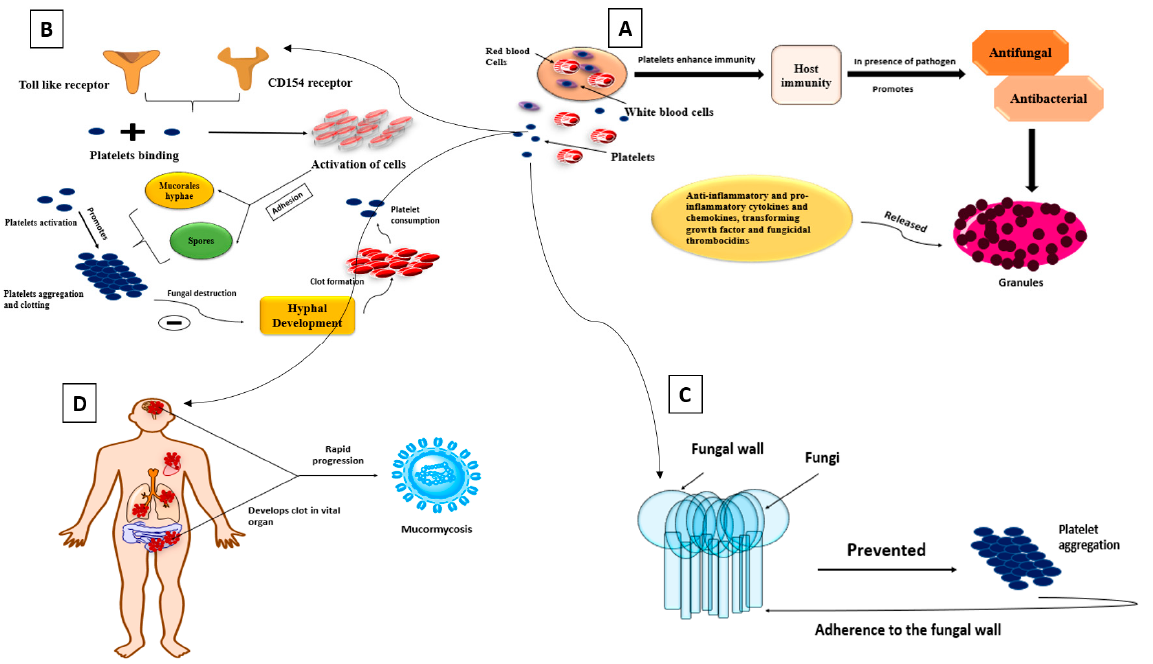
Figure 3. Schematic diagrams of platelets roles; ( A ) Platelets enhance host immunity, and after invading pathogen/foreign matter it promotes antifungal and antibacterial properties. Thus, various cytokines and chemokines released in granules; ( B ) The two membrane bound molecules such as TLR and CD154, it allows platelets binding and activates different cells. Thus, adhesion of mucorales hyphae and spores takes place, which causes platelets activation and leads to aggregation and clotting. Furthermore, inhibits hyphal development in presence of fungal destruction, which leads to clot formation and platelets consumption; ( C ) Prevention of fungi takes place due to the presence of platelet aggregation and therefore, it adheres to fungal wall; ( D ) COVID-19 patient develops clot in their vital organ and therefore progression of mucormycosis becomes rapid.